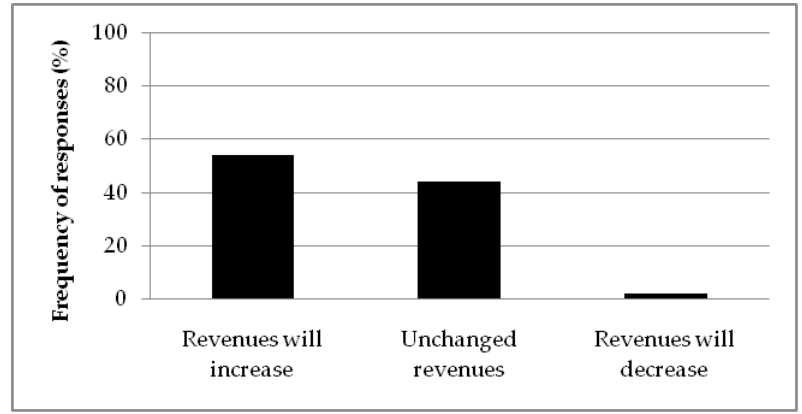
Figure 7. FDs FSC responsible persons’ answers to the question: What is your prognosis regarding the future revenues as result of FSC certification of forest management? (in